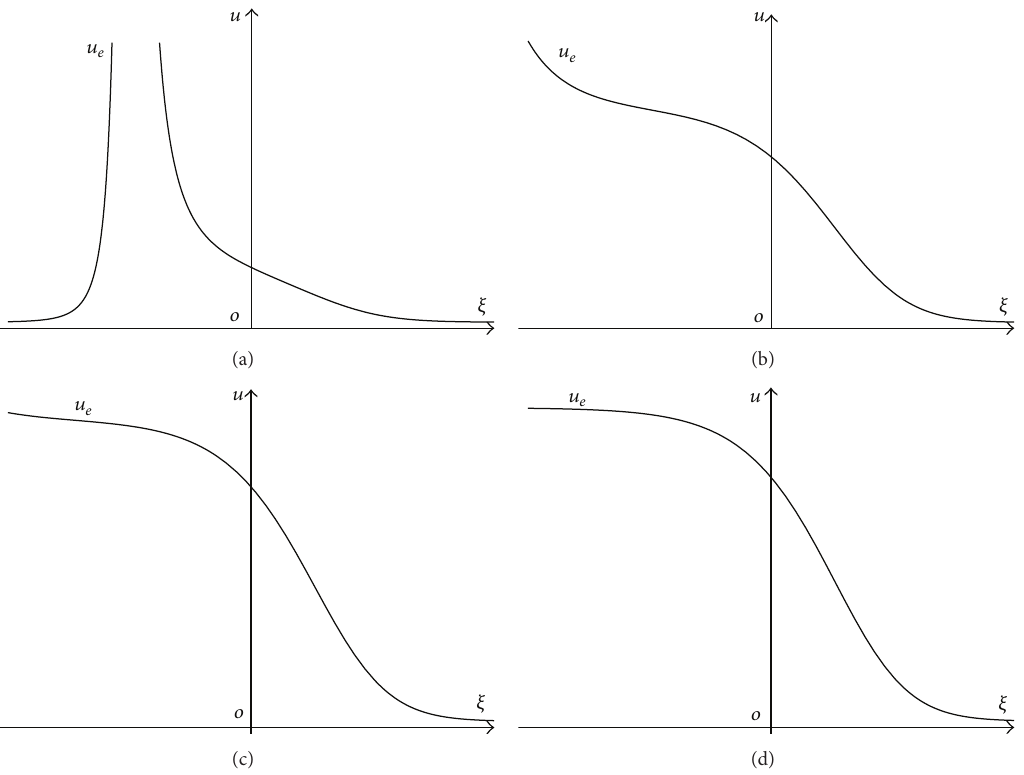
Figure 10: (The antikink wave is bifurcated from the blow-up wave). The varying process for the graph of 𝑢 𝑒 when 𝑐 > 0 , 𝛿 > 0 , 𝑎 > 0 , 𝜆 > 0 , and 𝑏 → −16𝑎 2 /75𝑐 − 0 , where 𝑐 = 1 , 𝛿 = 1 , 𝑎 = 1 , 𝜆 = 1 , and (a) 𝑏 = −16𝑎 2 /75𝑐 − 10 −2 . (b) 𝑏 = −16𝑎 2 /75𝑐 − 10 −4 . (c) 𝑏 = −16𝑎 2 /75𝑐 − 10 −5 . (d) 𝑏 = −16𝑎 2 /75𝑐 − 10 −9